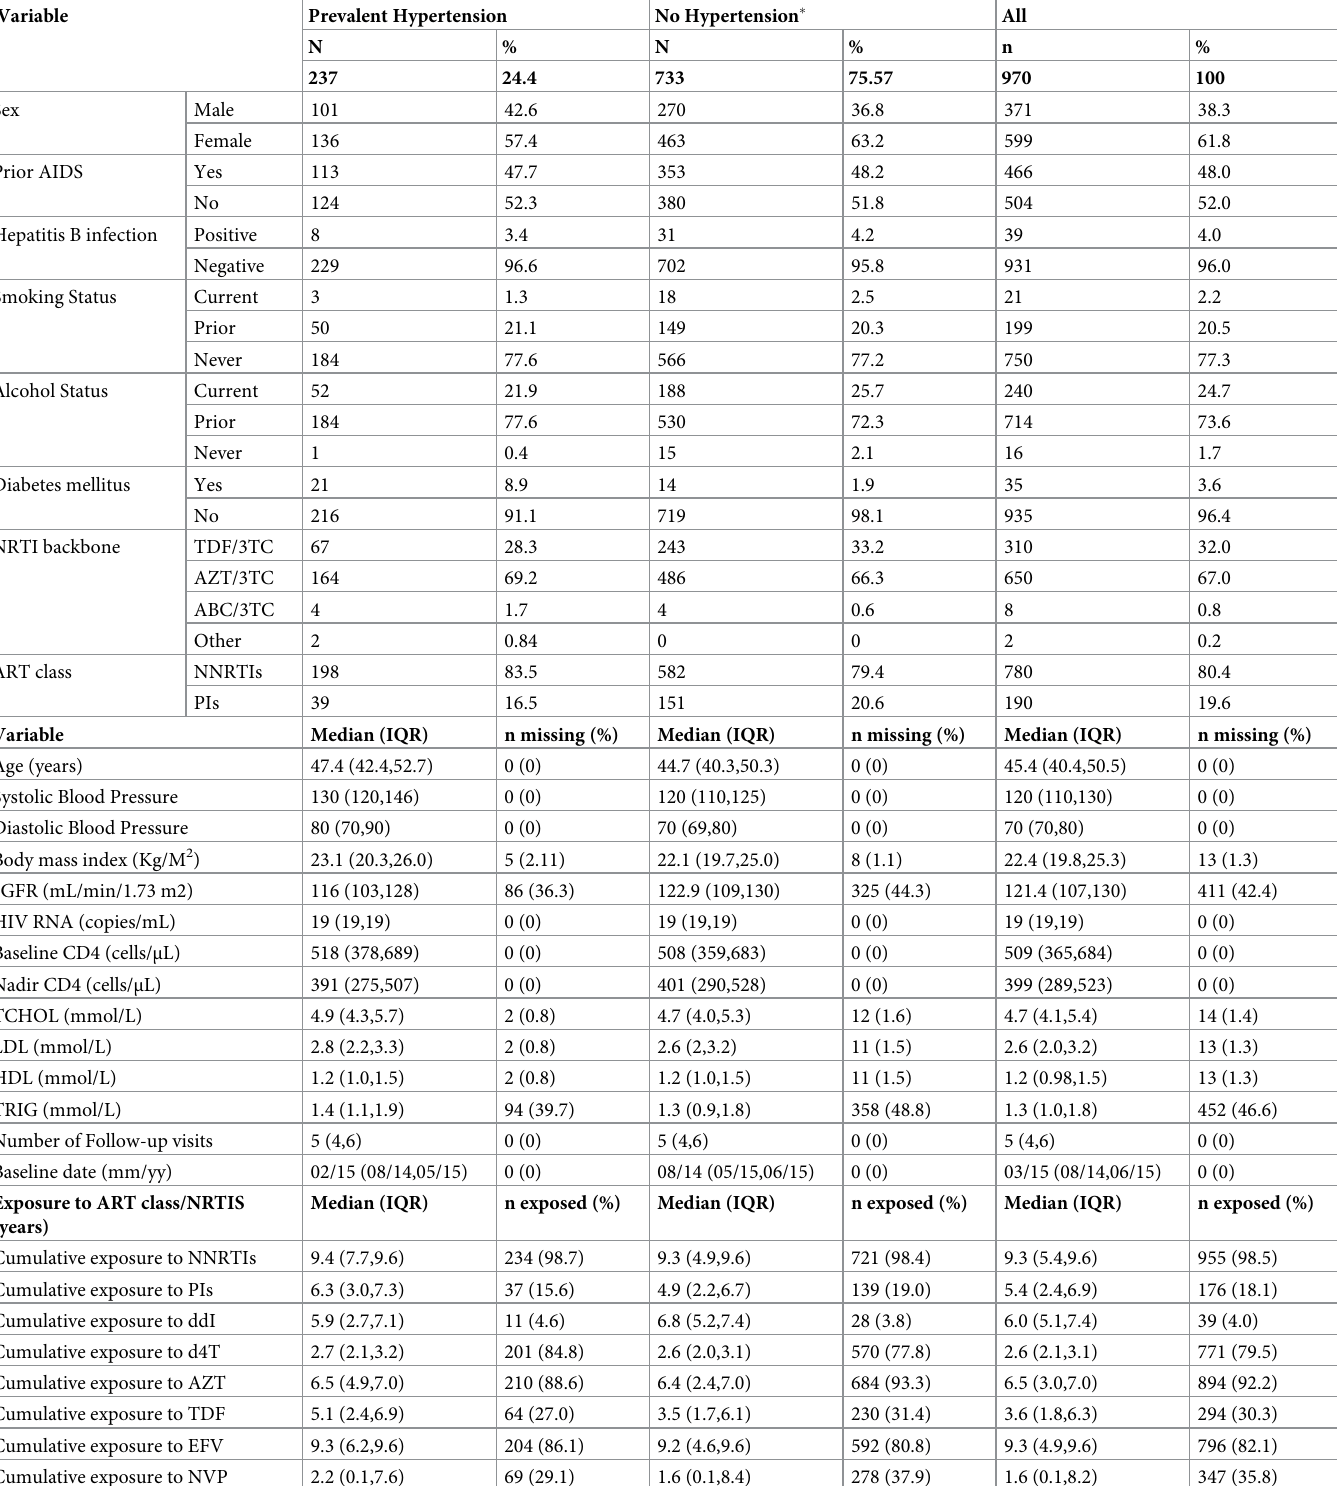
Table 1. Characteristics of participants with versus without hypertension at cohort enrolment (n = 970).